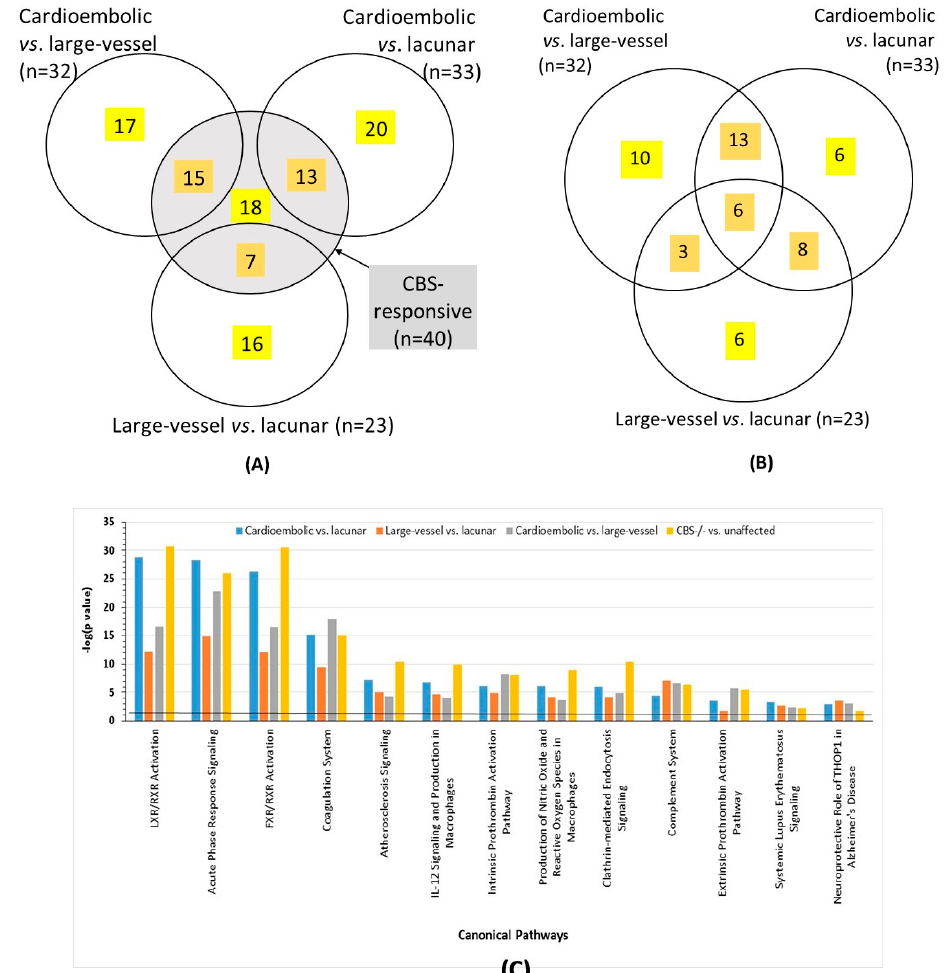
Figure 2. Distribution of di ff erentially expressed serum proteins between CBS deficiency and ischemic stroke subtypes ( A ), stroke subtypes only ( B ), and their canonical pathways ( C ). ( A , B ) The numbers of unique (yellow) and common (gold) proteins are indicated. The middle gray circle in ( A ) represents CBS deficiency responsive proteins. The total of the numbers in the middle gray circle ( n = 18 + 15 + 13 + 7 = 53) is greater than the number of CBS-responsive proteins ( n = 40) because some of the proteins a ff ected by both CBS deficiency and a stroke subtype ( n = 22) were also a ff ected by two or three stroke subtype comparisons (see Table 3). ( C ) Canonical pathways associated with ischemic stroke subtypes and CBS deficiency were identified by IPA. Benjamini–Hochberg, Bonferroni, and false discovery rate (FDR) corrections were applied to minimize the number of false